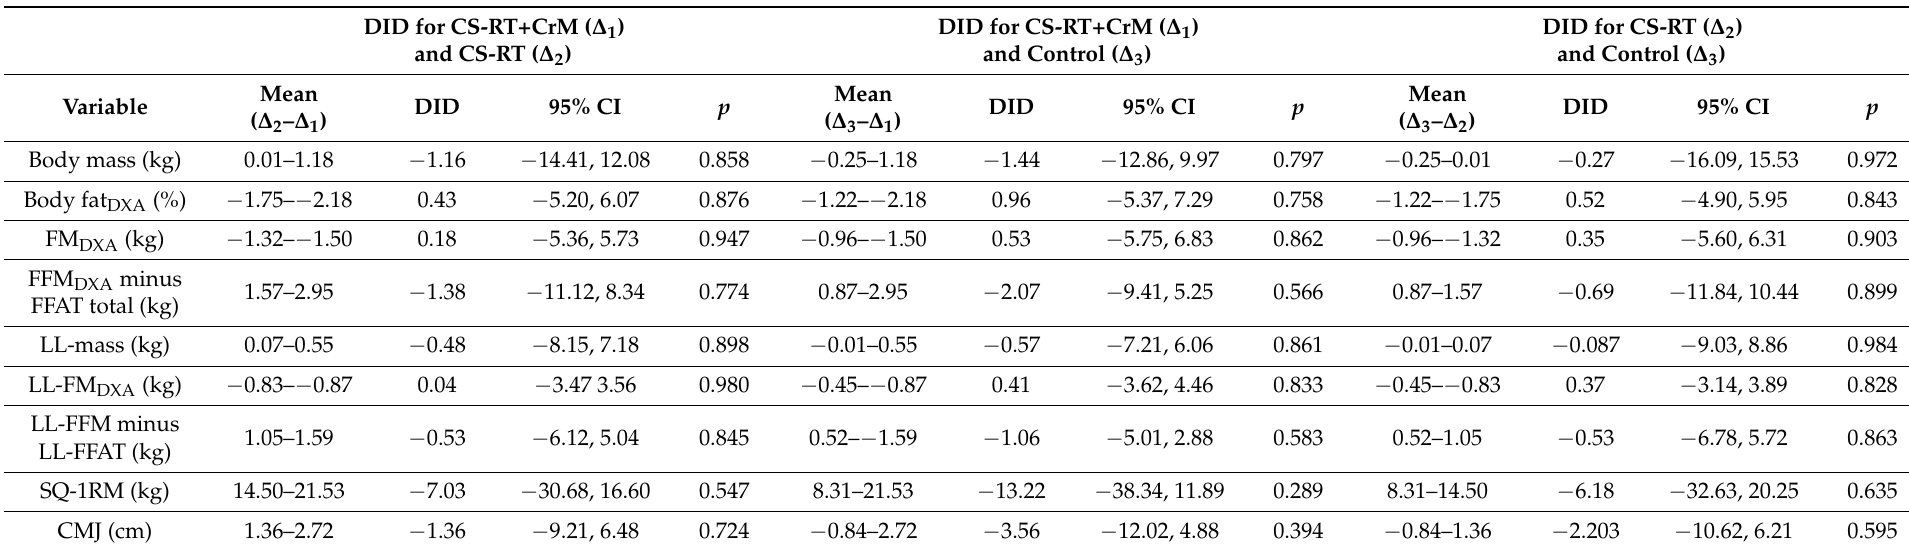
Table 4. Difference of differences between the studied